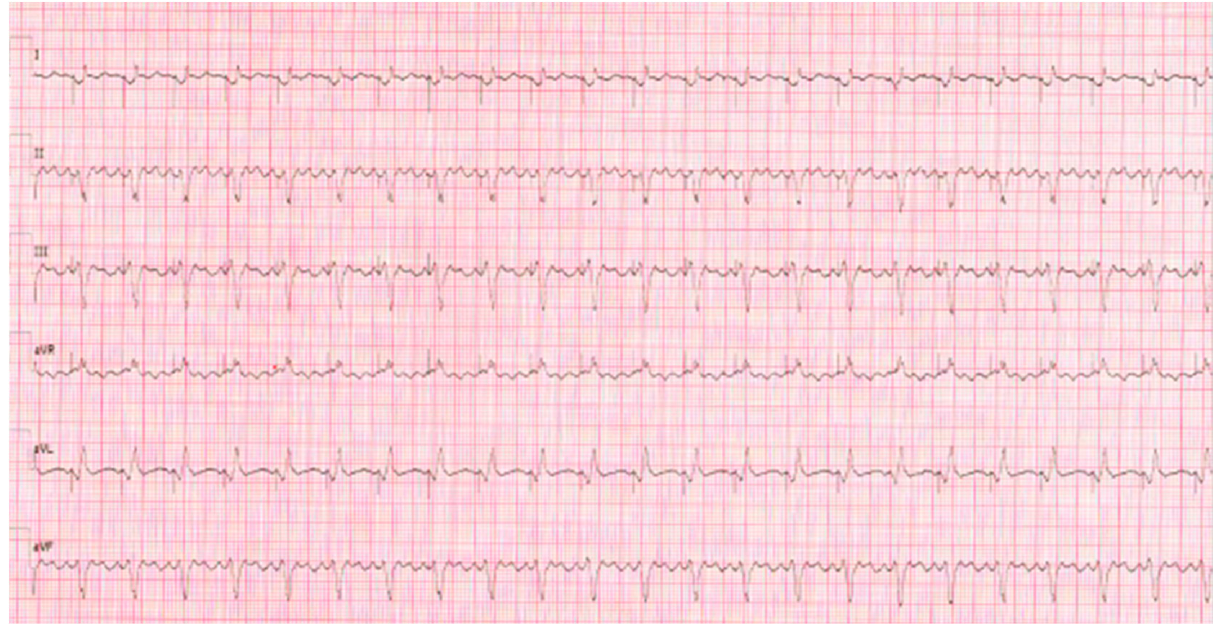
Figure 2. Atrial flutter 2:1. The pre-admission nasopharyngeal swab was positive for COVID-19, with all the other blood exams negative. C-reactive protein, the other inflammation tests, and troponin were negative. An echocardiogram was performed without signs of enlargement of both atria or valve insufficiency, ventricular dysfunction, or coronary dilatation. Anticoagulant therapy with subcutaneous heparin was started without considering an antiarrhythmic therapy, but the pacemaker was reprogrammed (DDIR 75–160 bpm) by obtaining a median heart rate of 80 bpm with persistent heart rhythm disorder. After 15 days of quarantine, the nasopharyngeal swab was negative. Remote control of the device showed the spontaneous restoration of the sinus rhythm in correspondence with the negativization of the swab (Figure 3). No further supraventricular arrhythmias were detected in the next short-term and medium-term